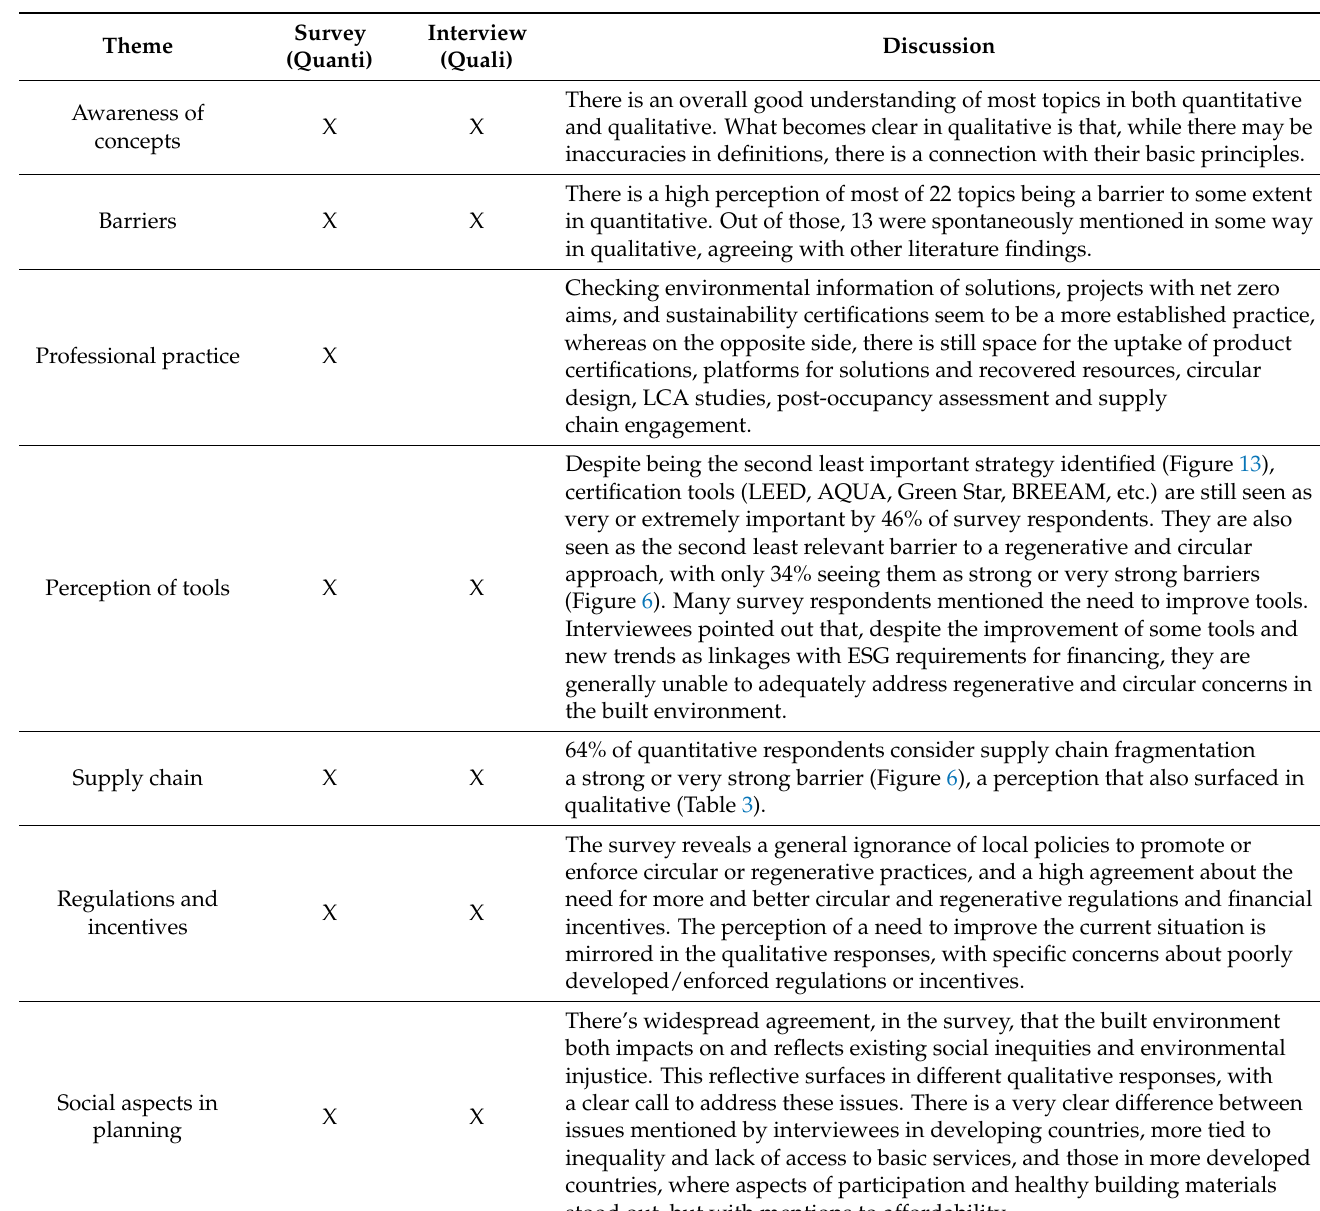
Table 9. Summary (integration) of quantitative and qualitative responses per theme of